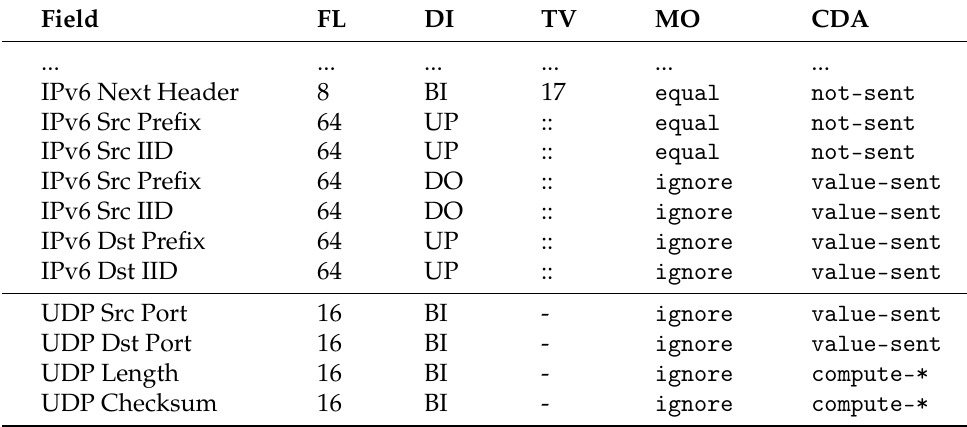
Table 1. Static Context Header Compression (SCHC) registration